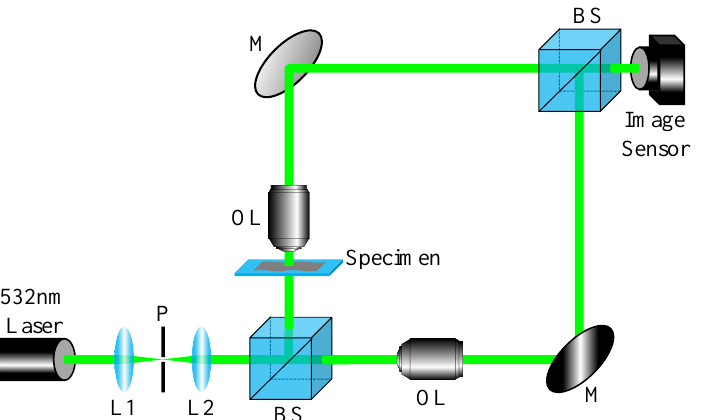
Figure 4. Experimental setup. L: lens, P: pinhole, M: mirror, BS: beam splitter, and OL: objective lens.